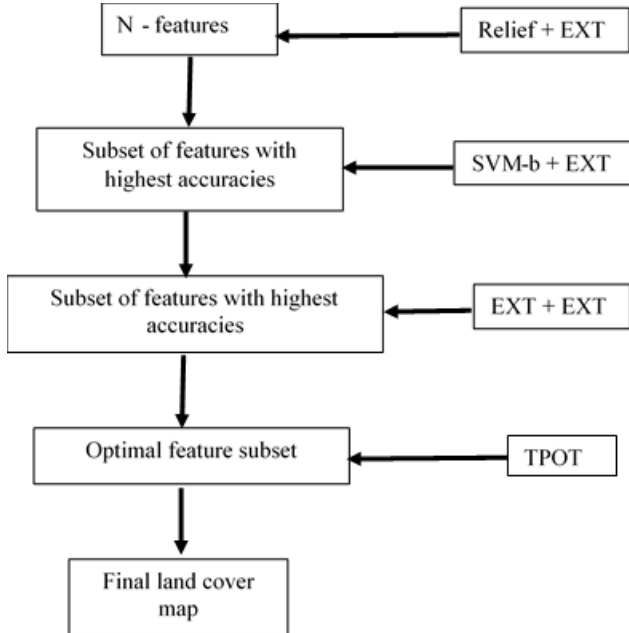
Figure 2. Flow chart of the proposed